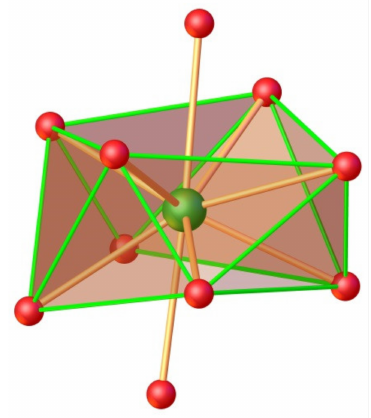
Figure 5. View of the asymmetric part of the unit cell in the crystal 4 with atom labeling and thermal ellipsoids at 50% level showing the coordination environment of Eu atom. Symmetry generated fragments are shown with faded colours. Symmetry code: 1.5 − x , y , 0.5 − z . Selected bond distances (Å): Eu-O1 2.512(2), Eu-O2 2.437(2), Eu-O3 2.508(2), Eu-O4 2.523(2), Eu-61 2.515(3).